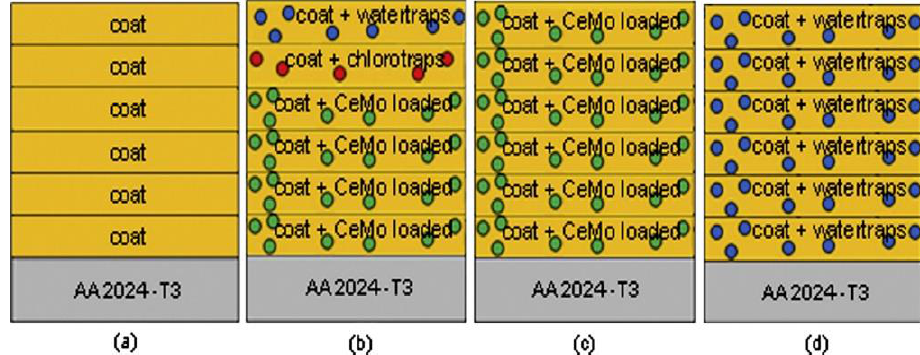
Figure 18. Samples consist of: ( a ) reference coating, ( b ) multifunctional coating, ( c ) inhibitor-loaded nanocontainers coating, and ( d ) water traps coating.